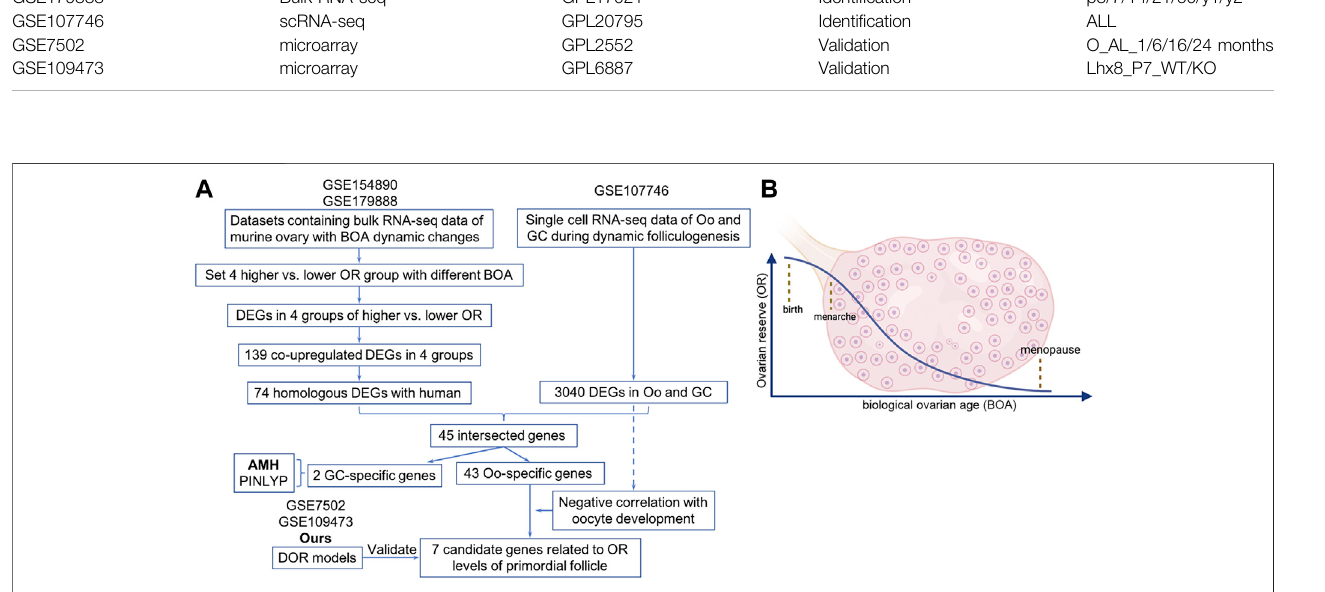
FIGURE 1 | The fl owchart of the design and analysis of this study.